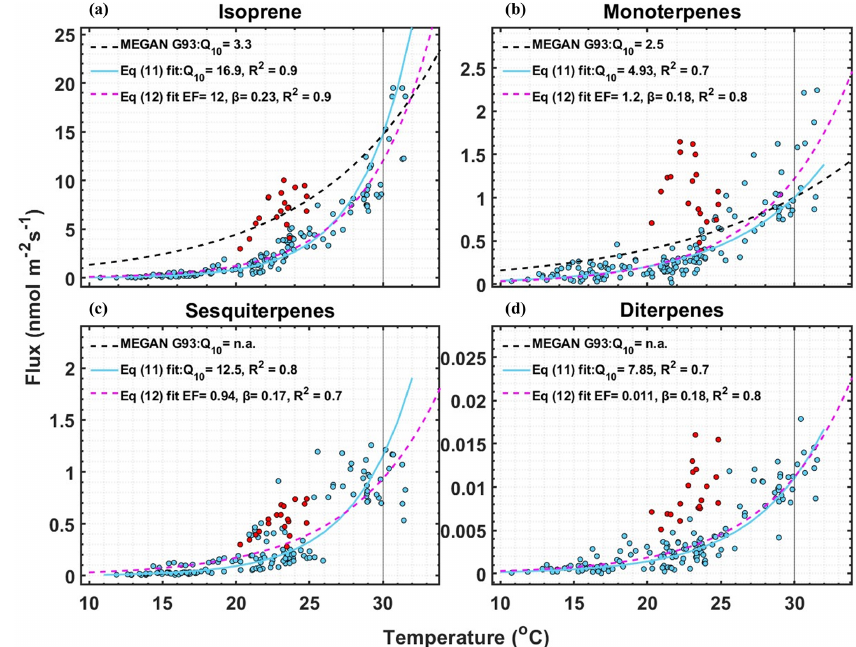
Figure 3. Measured fluxes of (a) isoprene, (b) monoterpene, (c) sesquiterpene, and (d) diterpenes fluxes vs. temperature of data points that passed EC quality criteria and that have PAR > 1000µmolm − 2 s − 1 . Q 10 values were calculated by fitting the data with Eq. (11). EF and β were calculated by fitting the data with Eq. (12). The dashed black line shows the relationship with leaf temperature of the temperature activity factor ( C T ) of the G93 model (Guenther et al., 1993), scaled to match emissions at 30 ◦ C. The red data points are the flux measurements after the maximum temperature day, 22 June 2021, when the air temperature crossed 31 ◦ C, and are not included in the